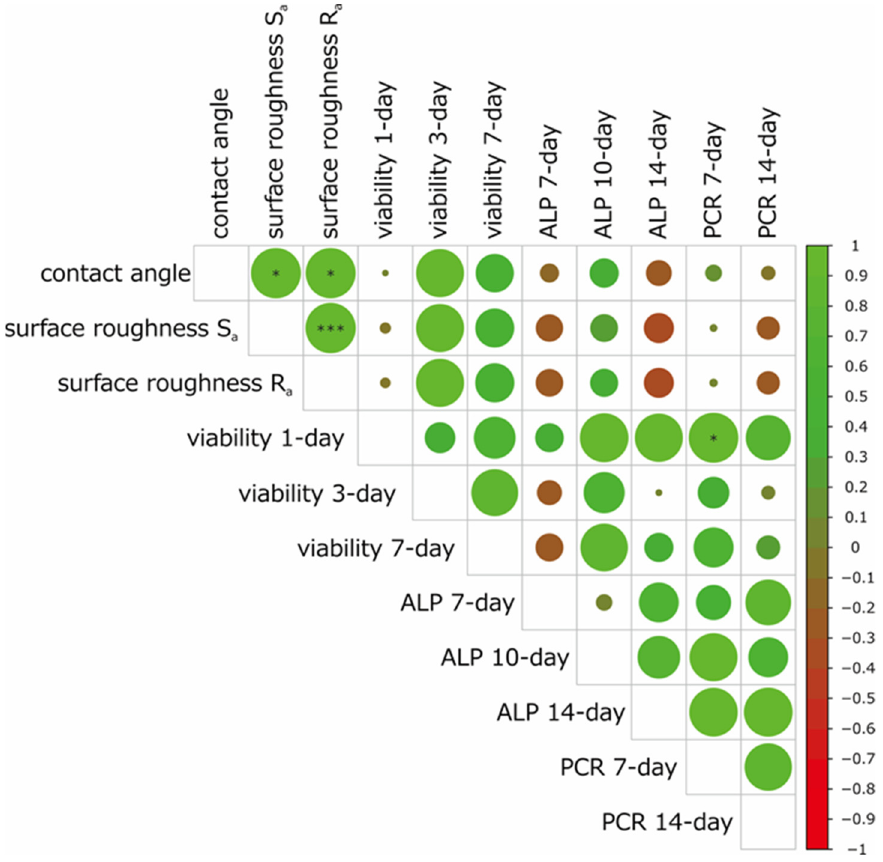
Figure 6. Results of the Pearson’s correlation analysis of each factor. Green and red circles denote positive and negative correlations, respectively. * α < 0.05; *** α < 0.001.